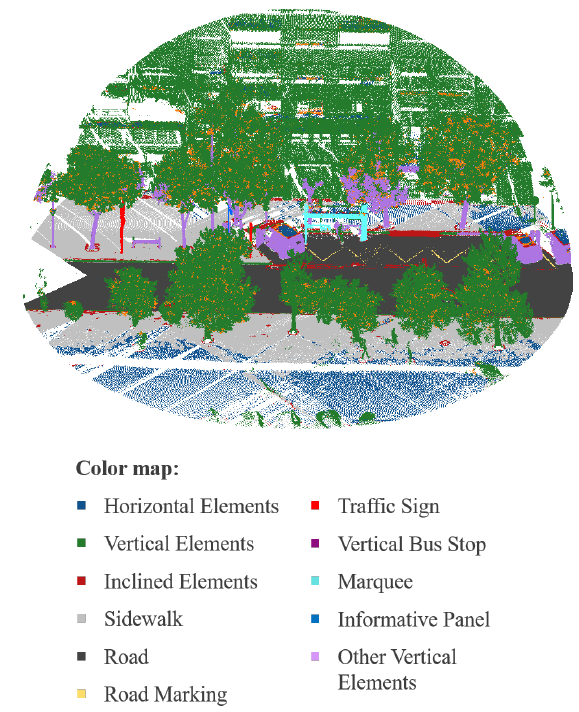
Figure 5. ROI of a bus stop with classified elements